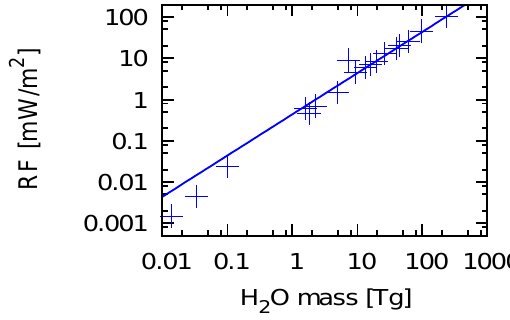
Fig. 8. Relation between change in atmospheric water vapour [Tg] and adjusted radiative forcing [mWm − 2 ] for a fixed emis- sion at different locations. Note that this relation is only valid if a constant emission is taken at different locations, which results in both different mass changes and different RFs. Data are from Grewe and Stenke (2008). The line represents a fit with RF = 4 . 38 × 10 − 13 Wm − 2 kg − 1 .